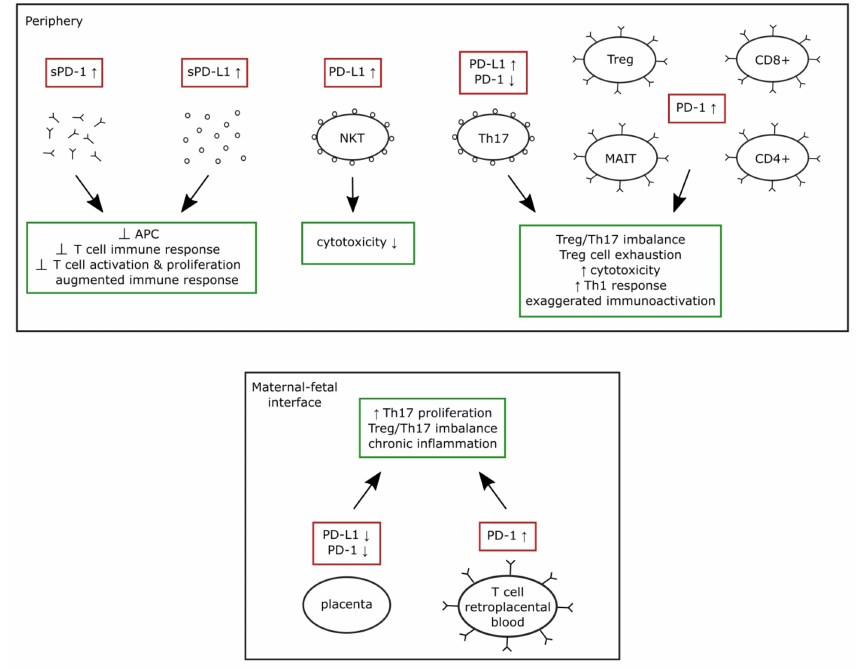
Figure 1. Summary of the described alterations of the PD-1/PD-L1 system in the periphery and maternal-fetal interface in preeclampsia and their effects on the immune system. Abbreviations: PD-1—programmed cell death protein 1; PD-L1—programmed death ligand 1; sPD-1—soluble programmed cell death protein 1; sPD-L1—soluble programmed death ligand 1; APC—antigen presenting cell; NKT—natural killer T cells; MAIT—mucosal associated invariant T cell; Th1—T helper 1 cell; Th17—T helper 17 cell; Treg—regulatory T cell; CD8+—CD8 positive T cell; CD4+—CD4 positive T cell; IL-17—Interleukin 17; IL-10—Interleukin 10; ⊥